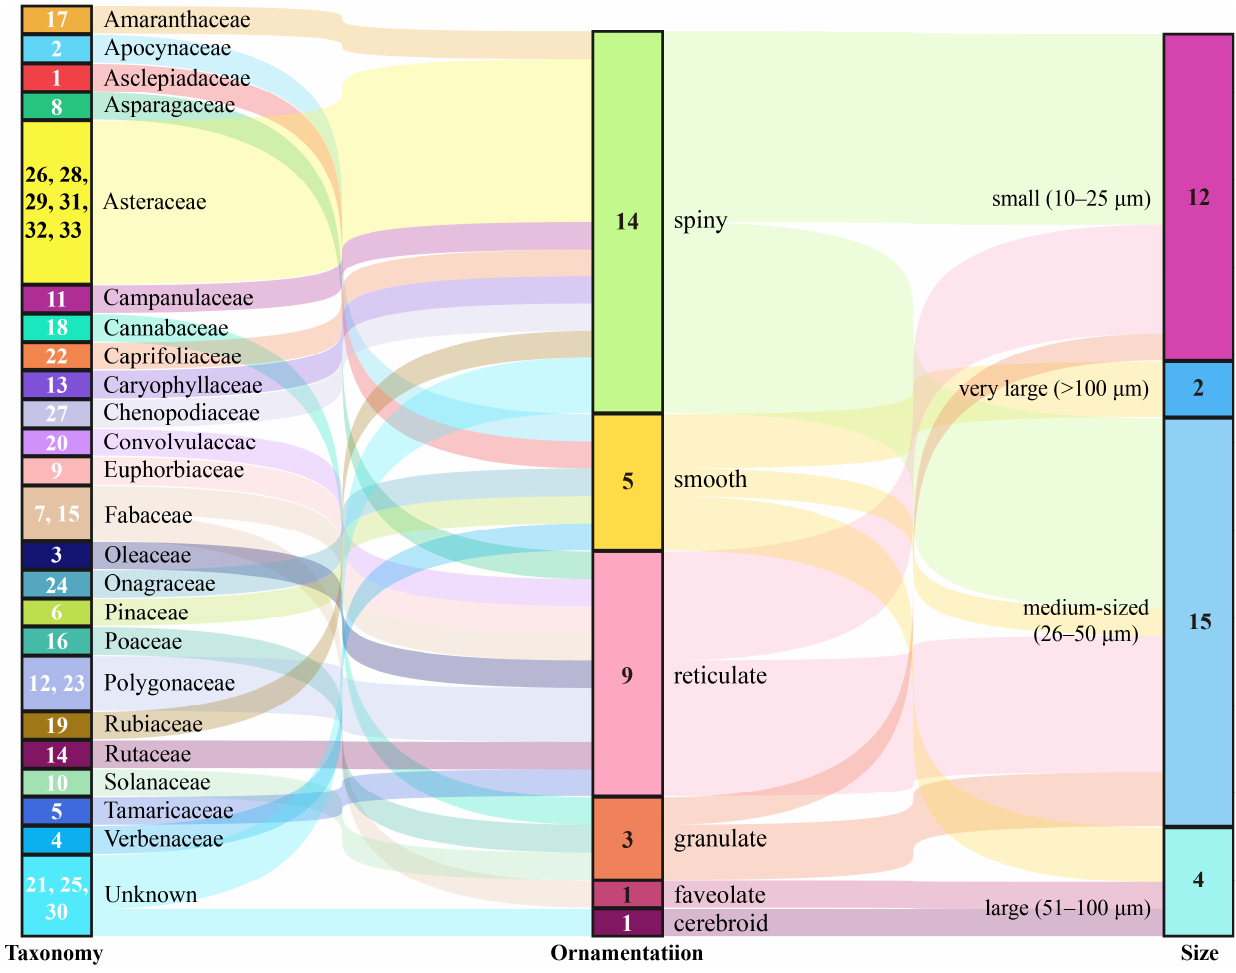
Figure 3. Sankey plots for the taxonomic information and morphological features of the examined pollen species. The number inside the Taxonomy bars represent the pollen type in Figure 2, while the numbers within the ornamentation and size bars denote sample sizes.